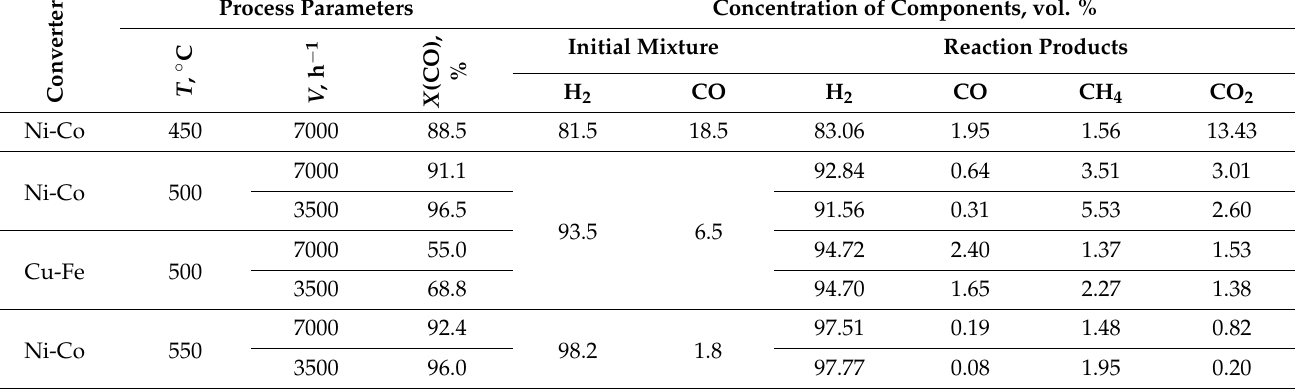
Table 3. Initial data and outlet characteristics of the steam reforming of carbon monoxide mixed with hydrogen. Concentration of Components, vol.